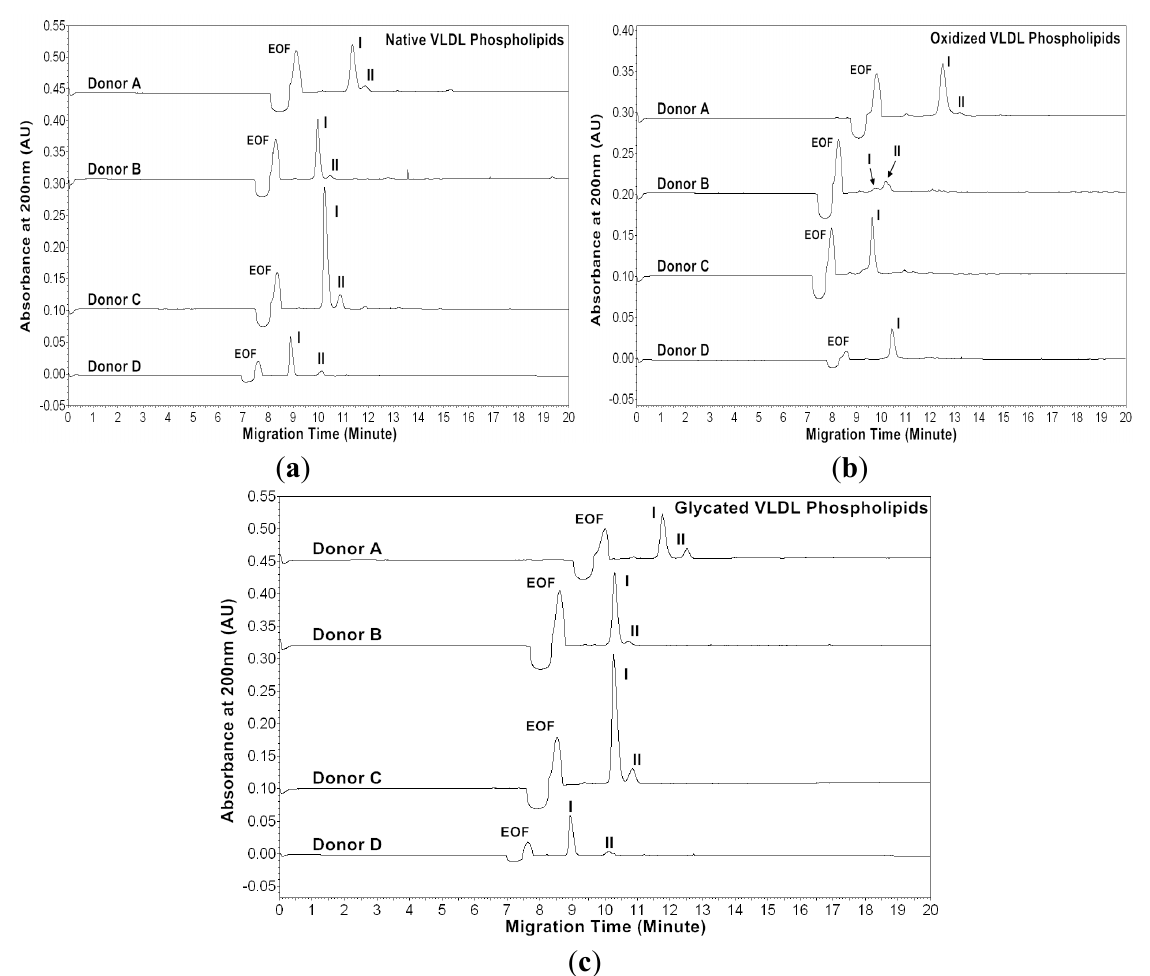
Figure 5. MEKC profiles of ( a ) native, ( b ) in vitro oxidized and ( c ) in vitro glycated VLDL phospholipids of four healthy subjects measured at absorbance 200 nm. CE voltage and temperature used were 25 kV and 40  C, respectively. A pressure of 0.5 psi and 32 s injection were applied. The separation buffer consisted of 50 mM bile salts + 10 mM PB